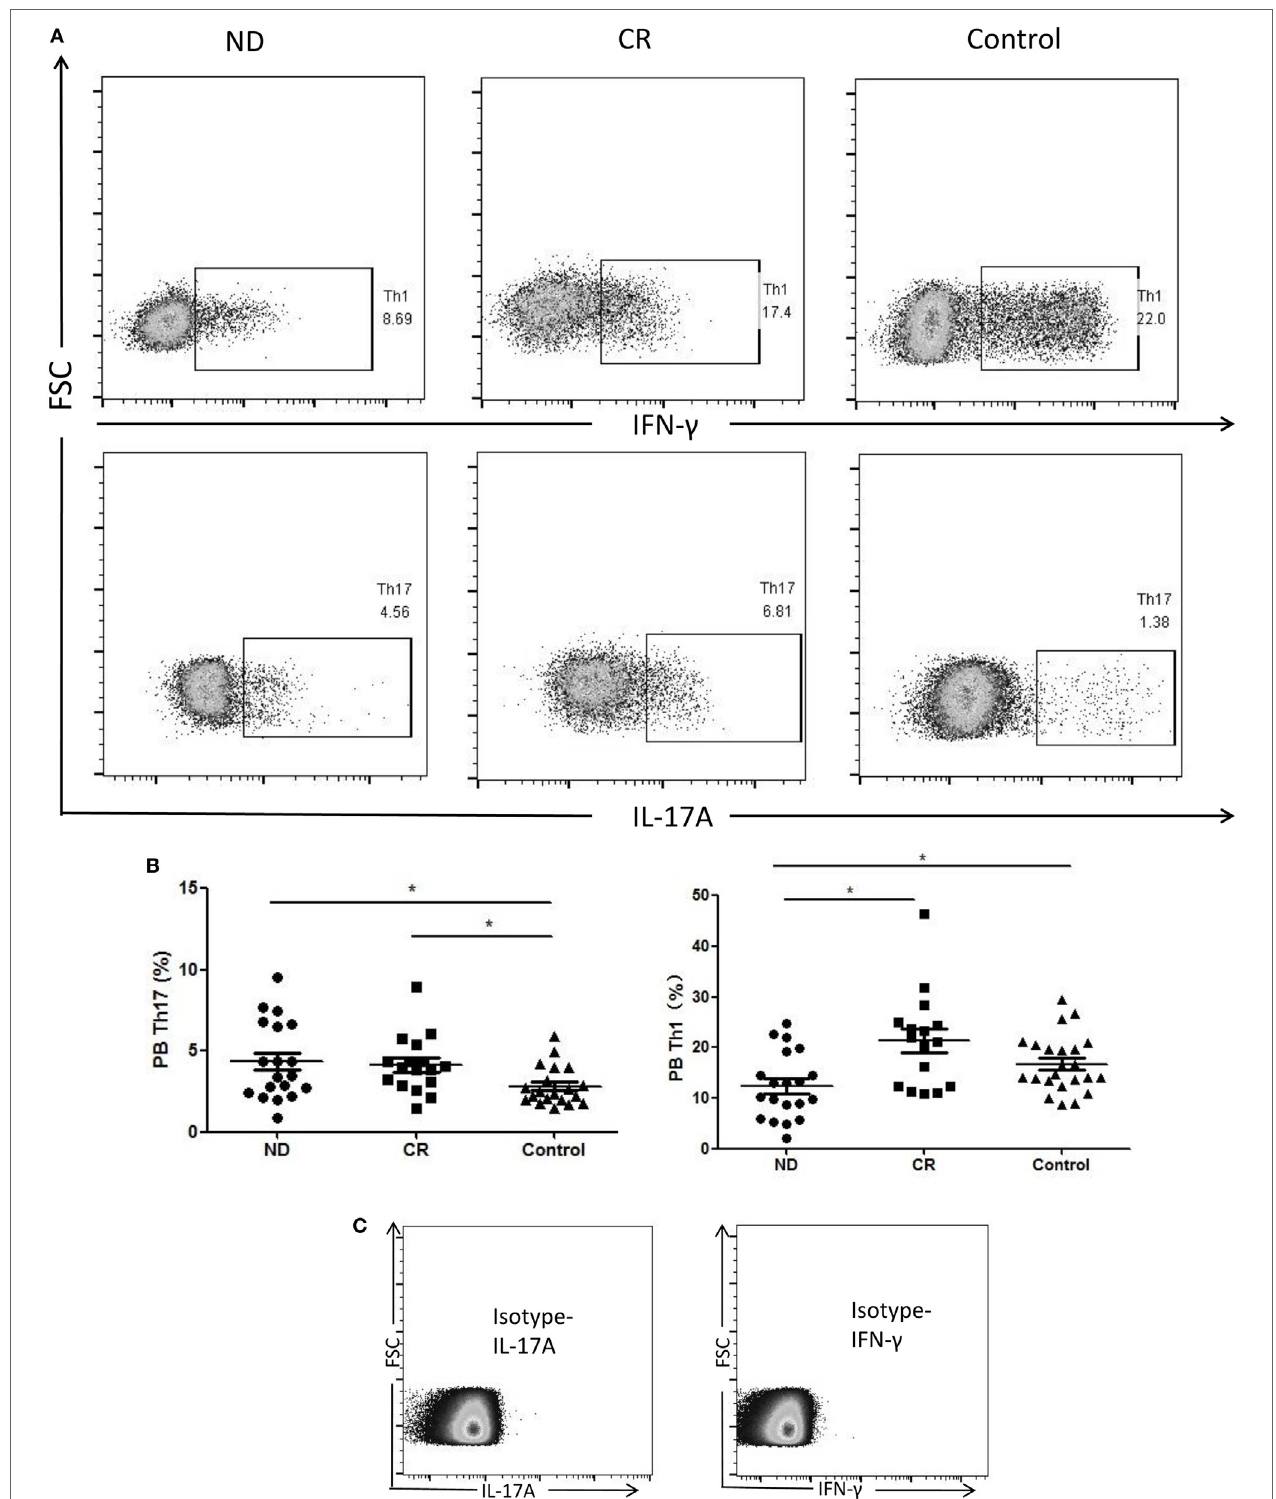
FigUre 2 | The results of circulating T helper (Th)1 and Th17 subsets in newly diagnosed (ND) acute myeloid leukemia (AML) patients, complete remission (CR) AML patients, and healthy controls. (a) Representative flow plots of Th1 and Th17 in ND AML patients, CR AML patients, and controls. (B) The percentage of circulating Th1 (CD4 + IFN- γ + ) cells was significantly decreased in ND AML patients compared with CR patients or controls; and Th17 (CD4 + IL-17A + ) cells was significantly increased in ND patients and CR patients compared with controls. (c) Isotypes were stained for IFN- γ and IL-17A.